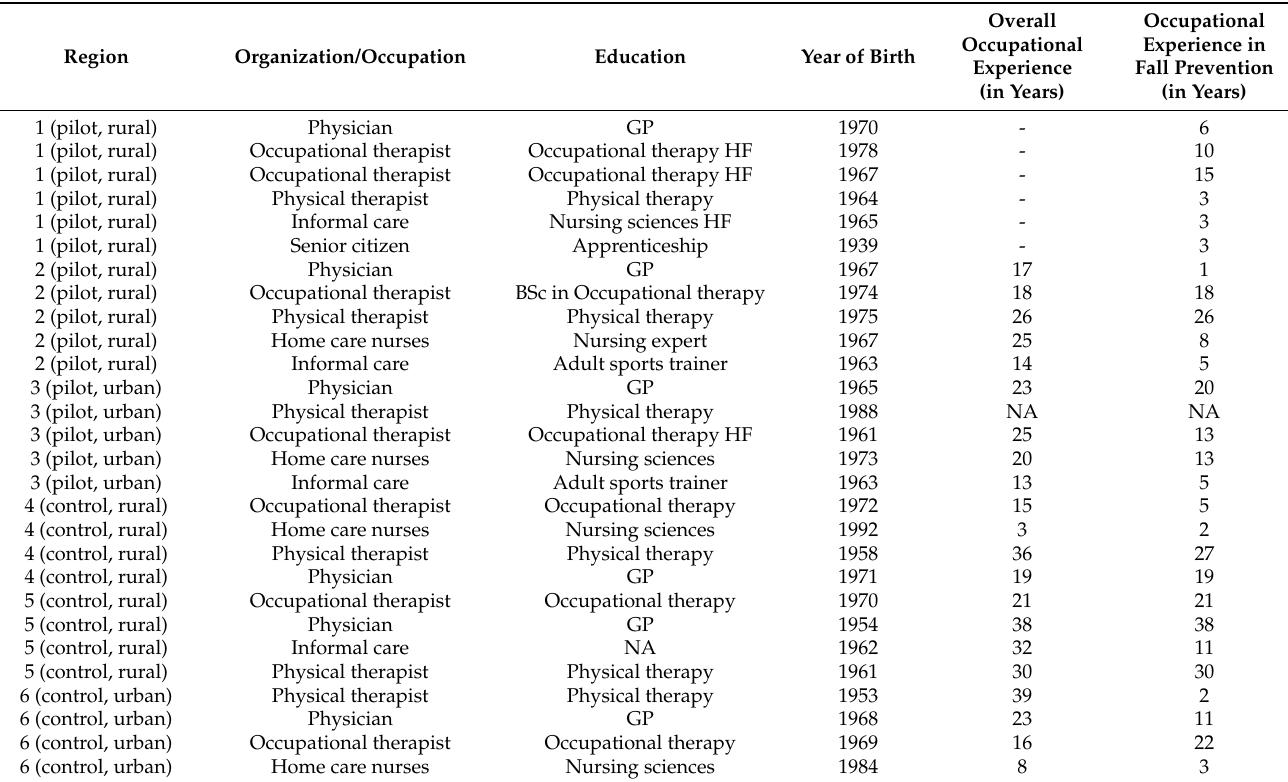
Table 1. Overview of the participants in the focus group and interviews (note: NA—no answer).